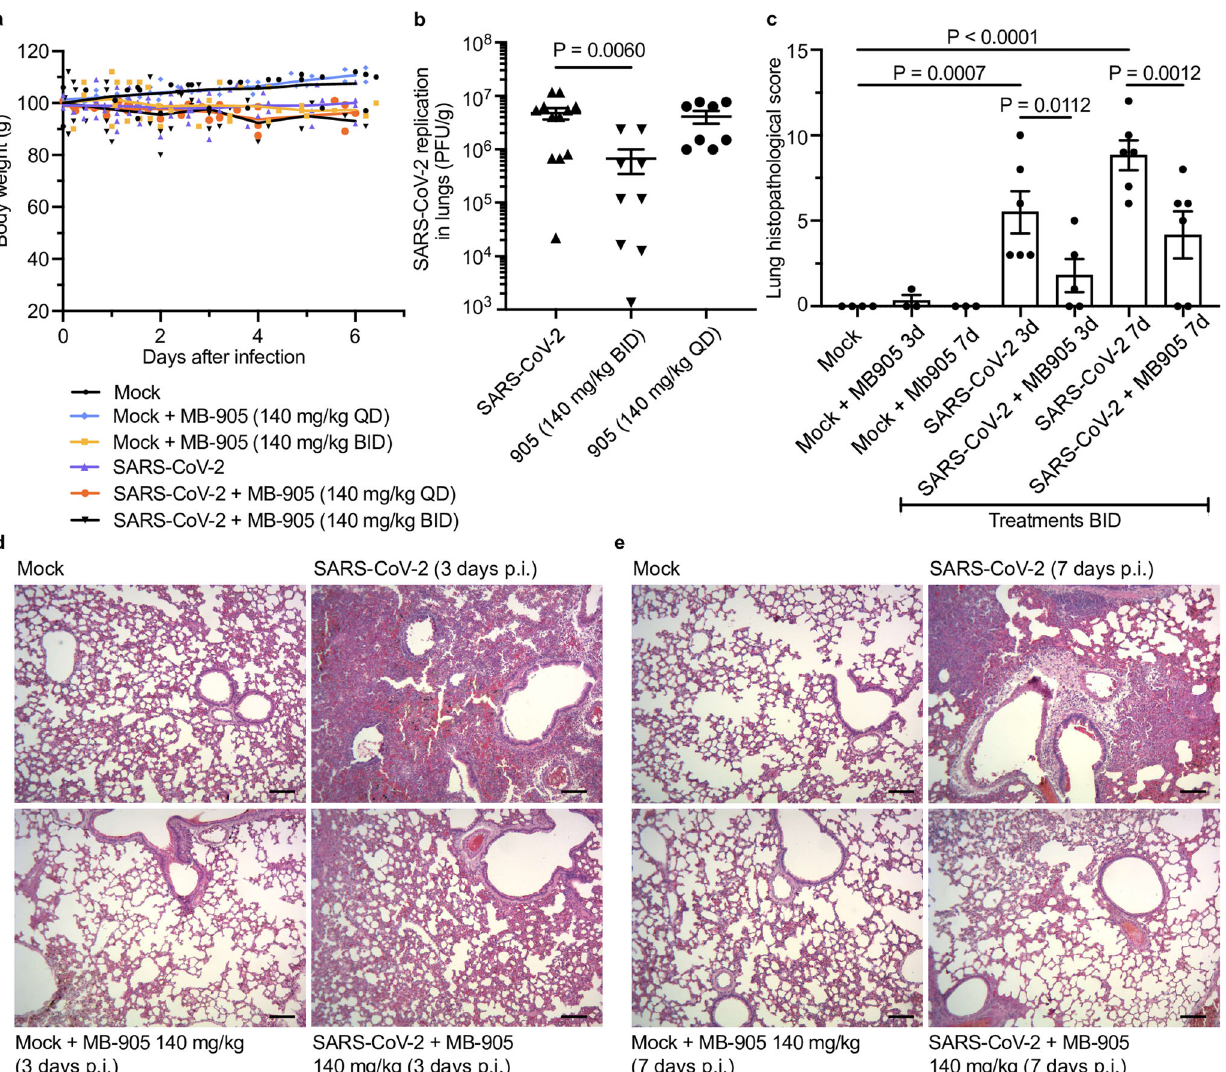
Fig. 7 | MB-905 reduces SARS-CoV-2-induced lung injury in hamsters. Male and female 6- to8-week-oldSyrianhamsters were inoculated(intranasally) with 100 μ L of saline (mock) or SARS-CoV-2 (10 5 PFU). Animals were analyzed for changes in body weight ( n =4 Mock, 6 Mock + MB905 140mg/kg BID, 7 Mock + MB905 140mg/kg QD, 12 nil/SARS-CoV-2, 8 SARS-CoV-2+MB905 140mg/kg BID and 8 SARS-CoV-2+MB-905140mg/kgQD)( a ).Infectiousvirustitersweredeterminedat the 3rd day after infection ( n =12 nil/SARS-CoV-2, 9 SARS-CoV-2+MB905 140mg/ kg BID and 8 SARS-CoV-2 + MB-905 140mg/kg QD) ( b ). Histological scores in the